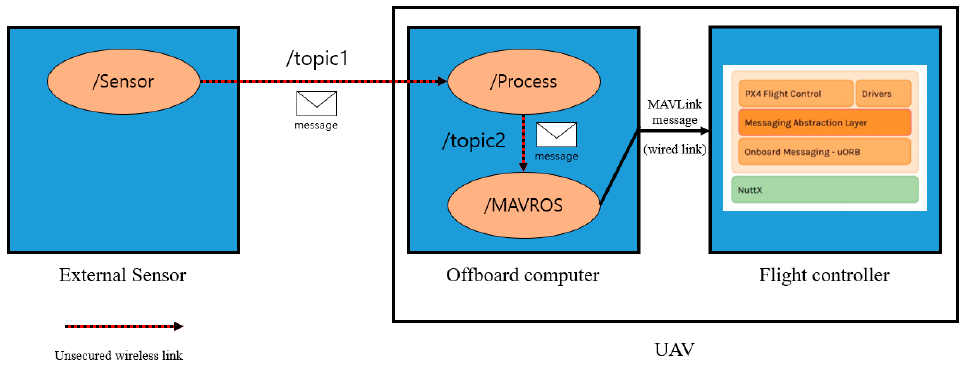
Figure 6. Feedback loop in an unmanned aerial system (UAS). Figure 7, the system model of UAV with ROS through the aforementioned procedure.